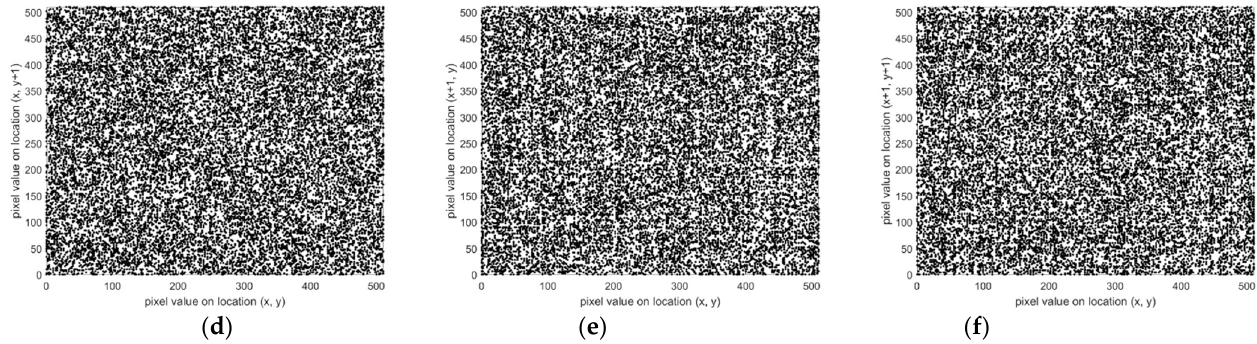
Figure 16. Adjacent pixel correlation of Lena (16BPP) and its corresponding cipher image: ( a ) Horizontal direction; ( b ) Vertical direction; ( c ) Diagonal direction; ( d ) Horizontal direction; ( e ) Vertical direction; ( f ) Diagonal direction.